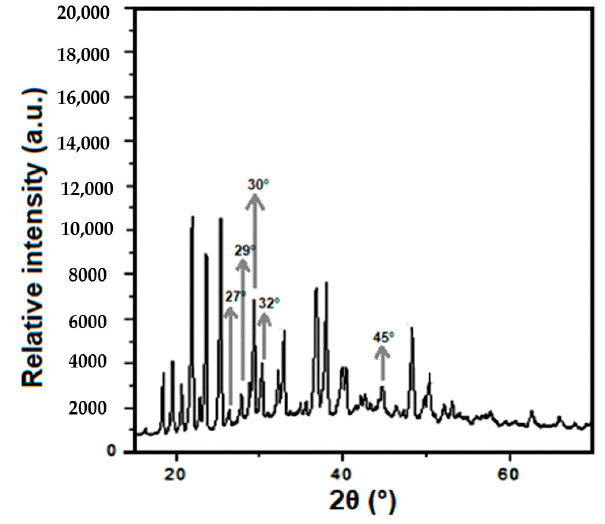
Figure 2. X-ray diffraction (XRD) spectra of CaCO 3 nanoparticles.